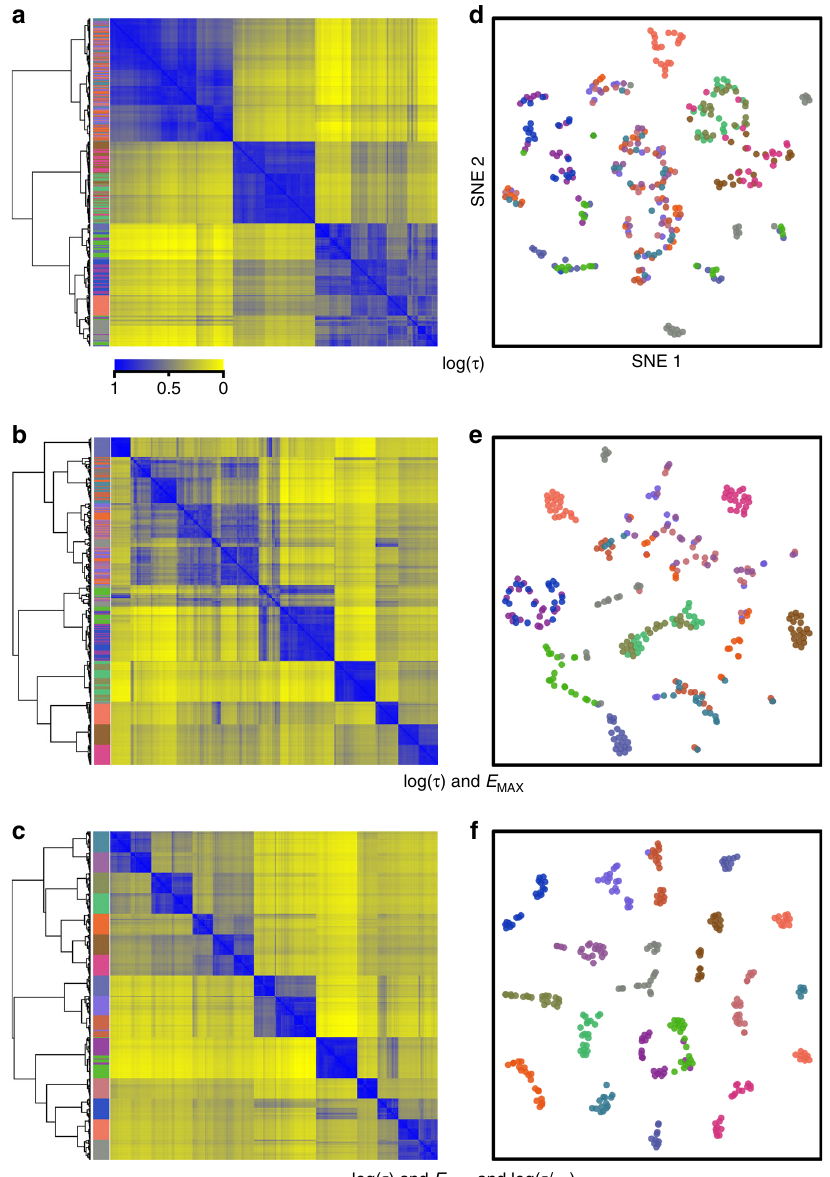
Fig. 1 Ligands are classi fi ed according to similarities in multidimensional signaling pro fi les using pharmacodynamic parameters. 320 virtual compounds were de fi ned by logistic and operational parameters to represent 16 distinct signaling pro fi les describing response at six different readouts. Indicated parameters were then subject to NNMF followed by k-means clustering, to produce corresponding similarity matrices that were represented as heatmaps and hierarchical clustering trees (using the R heatmap function with the metric:ward.D2) ( a – c ) or t-SNE plots (using the R package tsne with default parameters) ( d – f ). Ligands were color-coded to highlight how different combinations of parameters differentiated compounds originating from the